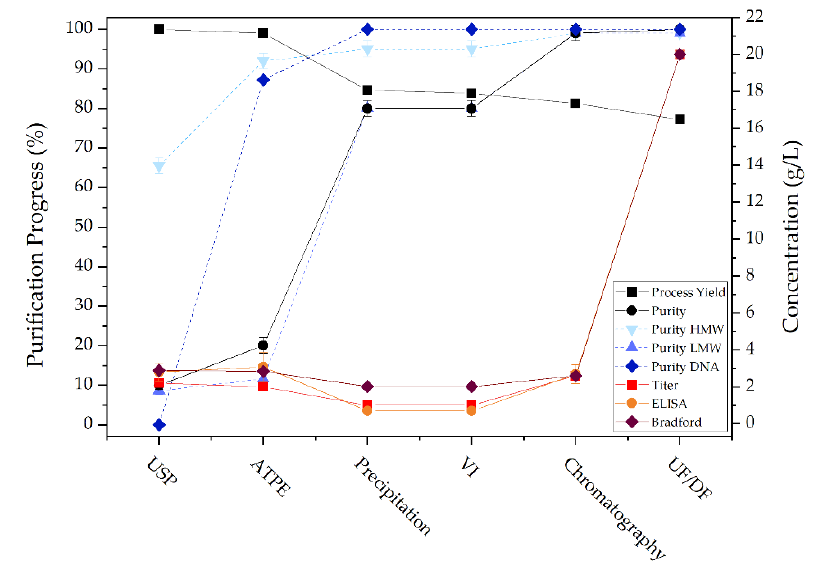
Figure 17. Course of purity, yield, and titer during the process.